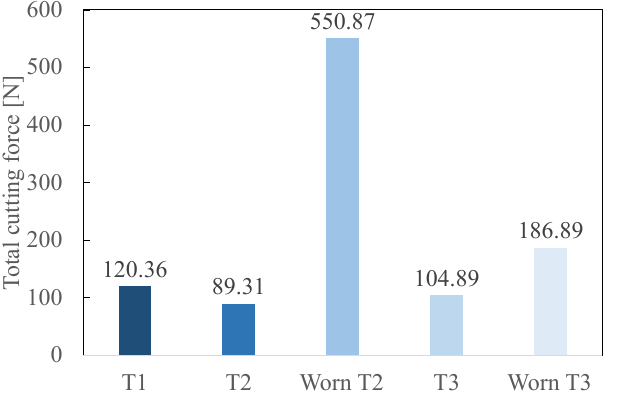
Figure 13. Total Cutting Forces, F tot , recorded during the milling (fresh and worn cutting tools).